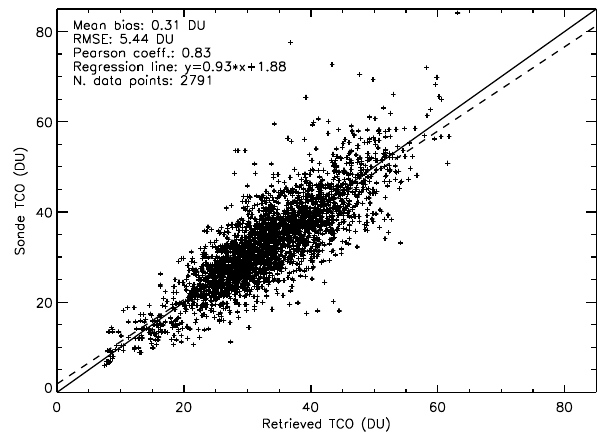
Fig. 2. Overall validation results, obtained both during and after the time period covered by the training